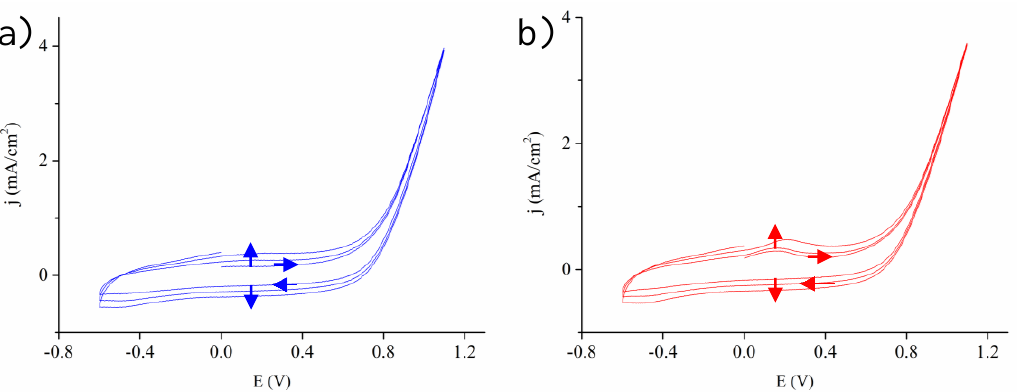
Figure 3. The cyclic voltammetry (CV) profiles for 3 cycles for the conformal deposition of ( a ) PEDOT and ( b ) PEDOT/Au on the skeletons of Ni inverse opals.